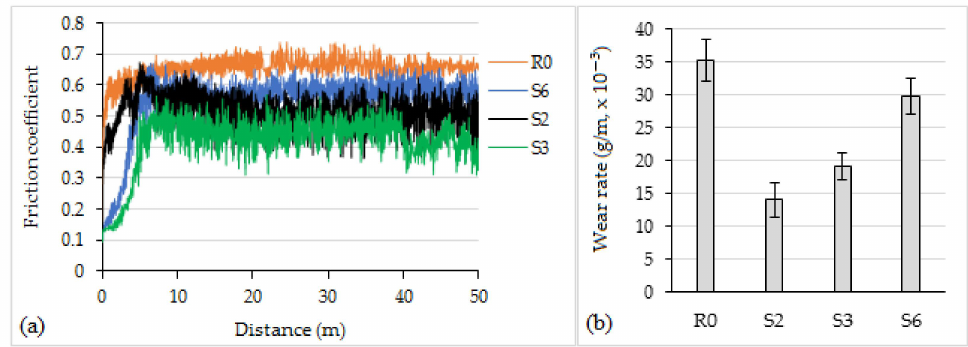
Figure 8. Friction coefficient curves ( a ) and wear rate of coatings ( b ) during a dry sliding